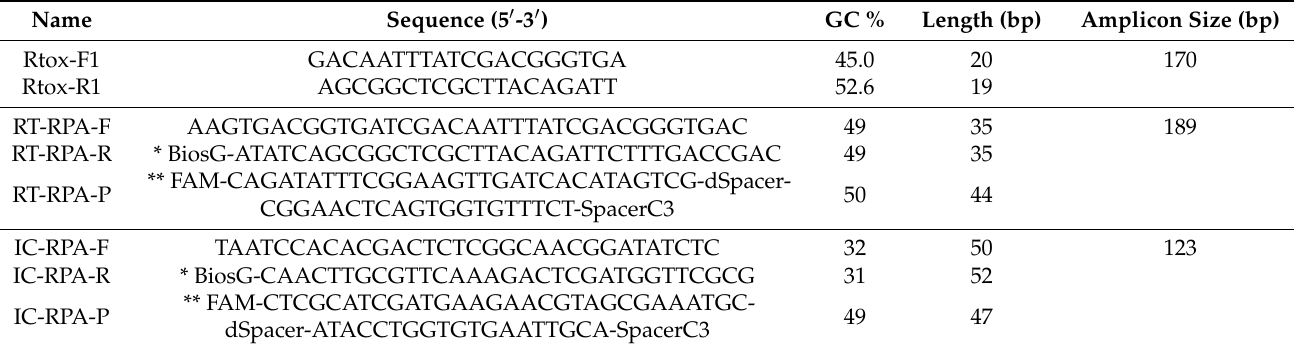
Table 2. Characteristics of the primers and probes used in the endpoint PCR (Rtox-F1 and Rtox-R1) and recombinase polymerase assays for the detection of Rathayibacter toxicus (RT-RPA-F, RT-RPA-R*, and RT-RPA-P) and its host Lolium rigidum (host control: IC-RPA-F, IC-RPA-R*, and